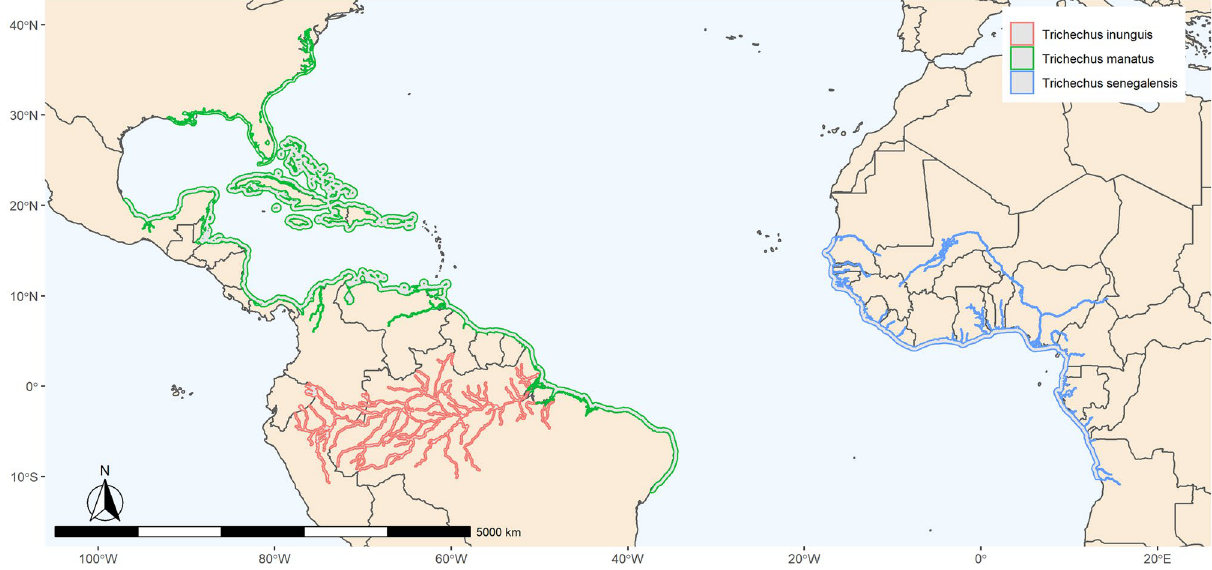
Figure 1. Distribution of Trichechus species in the world, map made by EMSS with Rstudio v.1.3 using distribution shapefile from IUCN database, script available at author’s Github webpage (https ://githu b.com/ souza ems/scrip ts/blob/maste